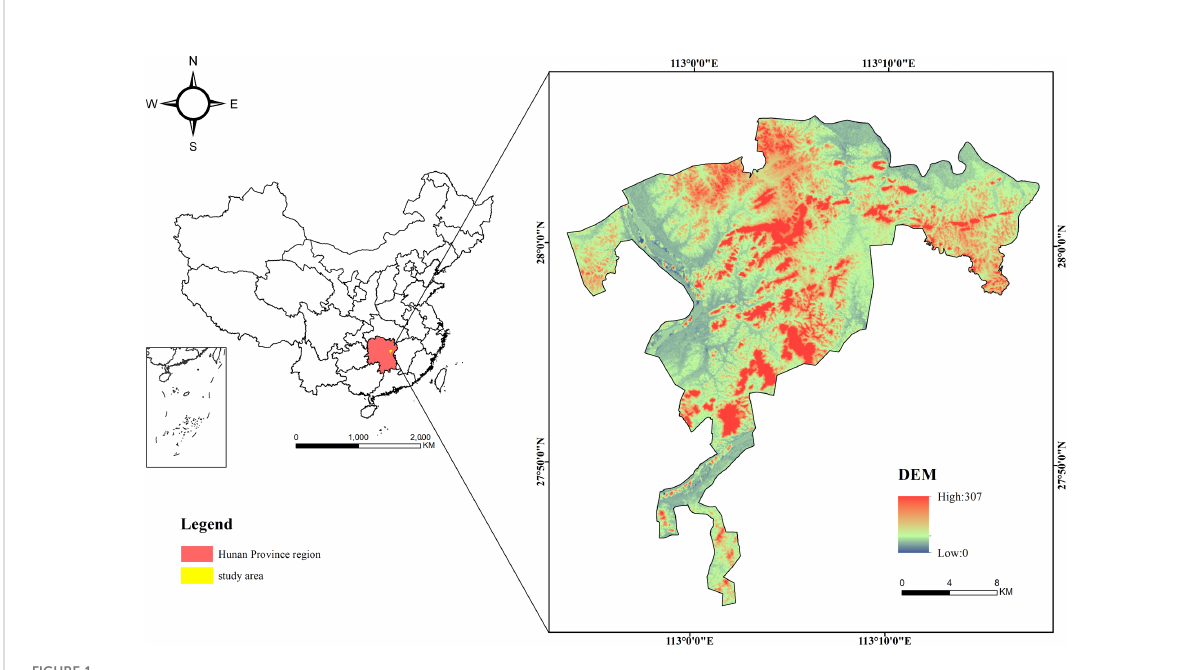
FIGURE 1 The location of the study